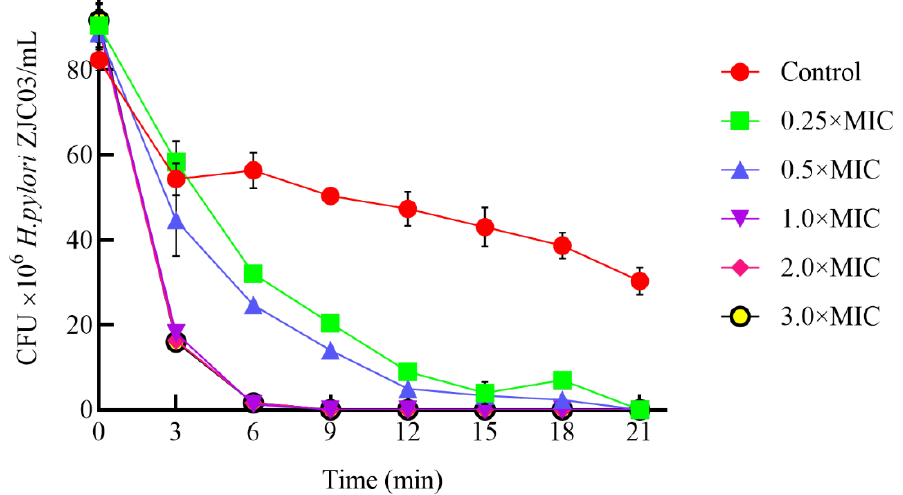
Figure 6. Hydrogen peroxide sensitivity of H. pylori ZJC03. Broth cultures of H. pylori ZJC03 treated with or without 0.25, 0.5, 1.0, 2.0, or 3.0 × MIC PLNC8 were added to 100 mmoL/kg hydrogen peroxide solution and evaluated by CFU determination every 3 min for 21 min in total; Control: 0.05% acetic acid buffer.